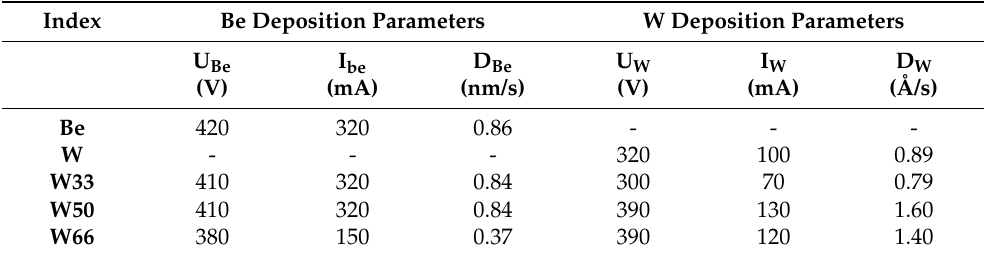
Table 1. Main deposition parameters for the mixed and reference D containing layers.